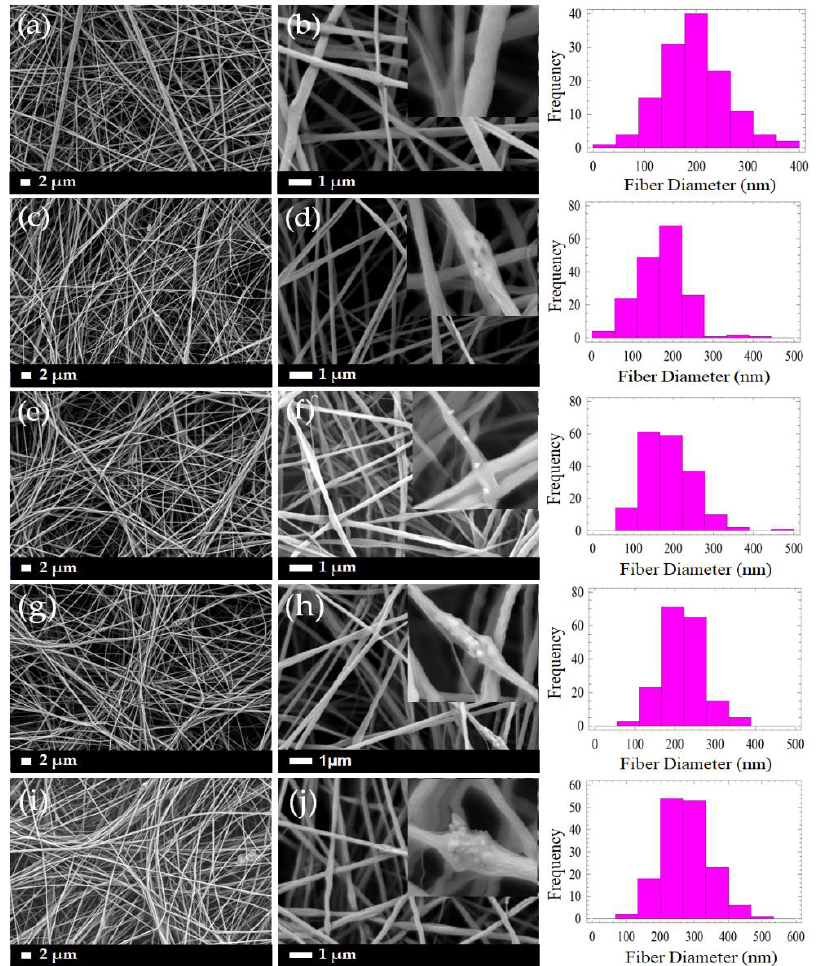
Figure 4. Morphology of the PLLA/CMS/β -TCP composite nanofibers with different compositions of β -TCP at different magnifications of 2000× and 10,000× ( a , b ) PLLA/CMS ( c , d ) 0.25% β -TCP, ( e , f ) 0.5% β -TCP, ( g , h ) 0.75% β -TCP and ( i , j ) 1% β -TCP in PLLA/CMS.